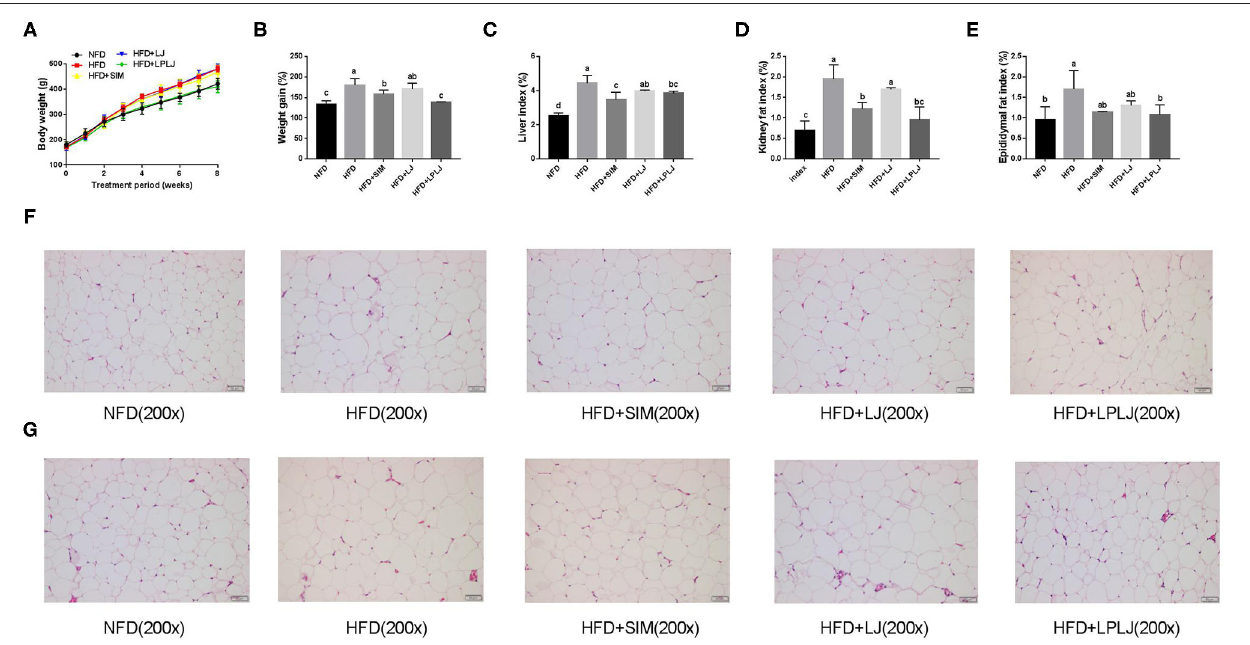
FIGURE 1 | Effects of LPLJ consumption on (A) body weight, (B) weight gain, (C) liver index, (D) kidney fat index, (E) epididymal fat index, (F) the size of perirenal adipocytes and (G) the size of epididymal adipocytes in rats fed a high fat diet. a-c, Mean values with different letters in the same column differ significantly ( p <